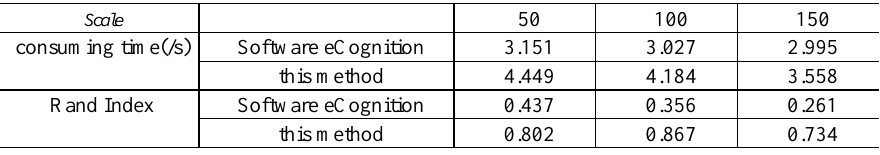
Table 2 . The quantitative assessment of the segmentation results of ZY-3 satellite